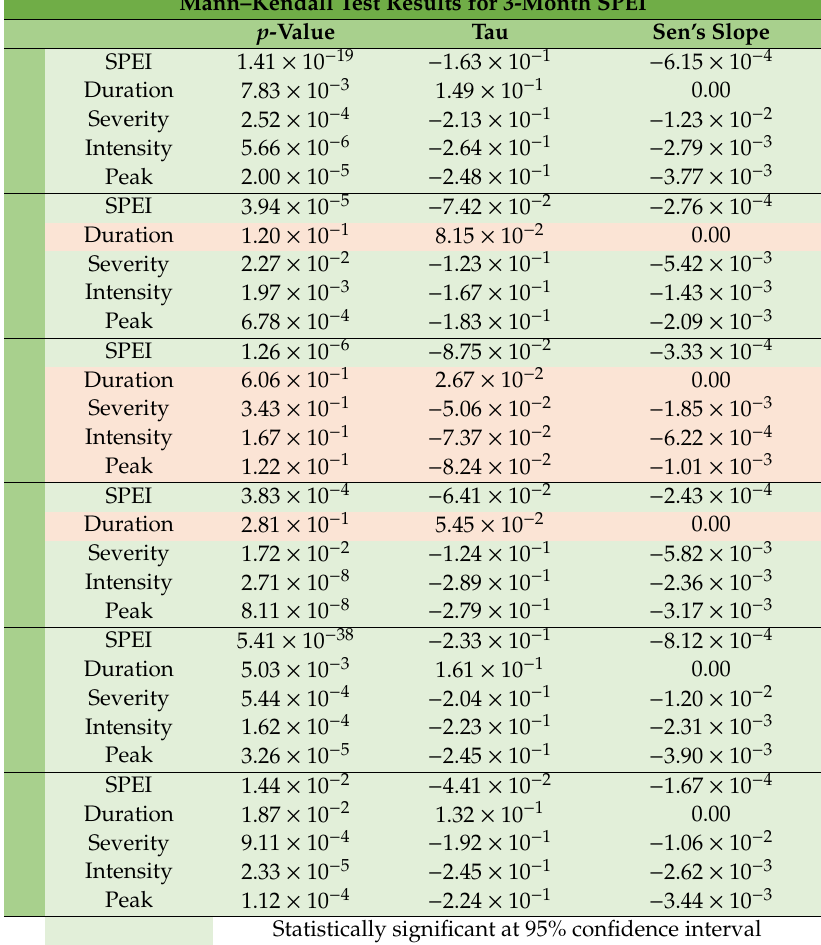
Table 1. Mann–Kendall test results for 3-month SPEI. Mann–Kendall Test Results for 3-Month